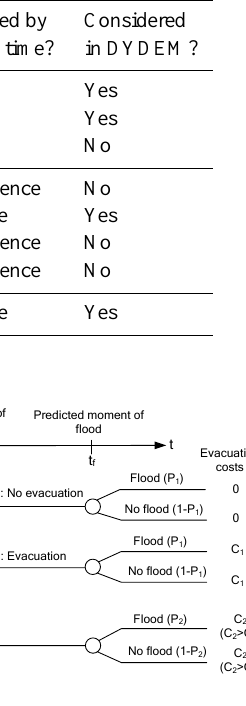
Fig. 1. Decision tree for dam-break emergency management (modified from Frieser, 2004).